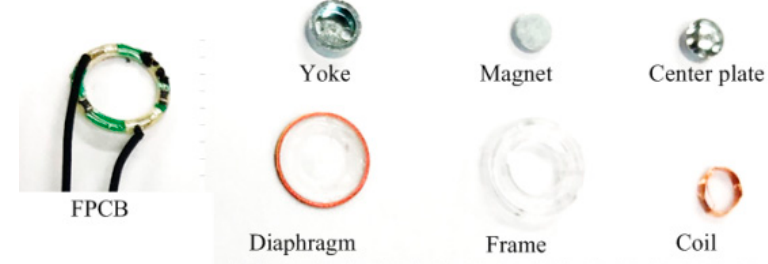
Figure 22. Components of dynamic earphone.